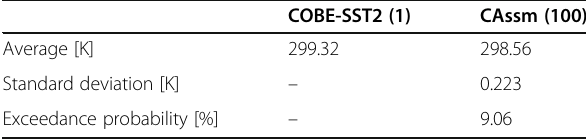
Table 3 Averages and standard deviations of SST JP for August 2010, and exceedance probabilities over Δ SST JP in COBE-SST2 for August 2010 in CAssm. Numbers in parentheses represent the number of samples for August